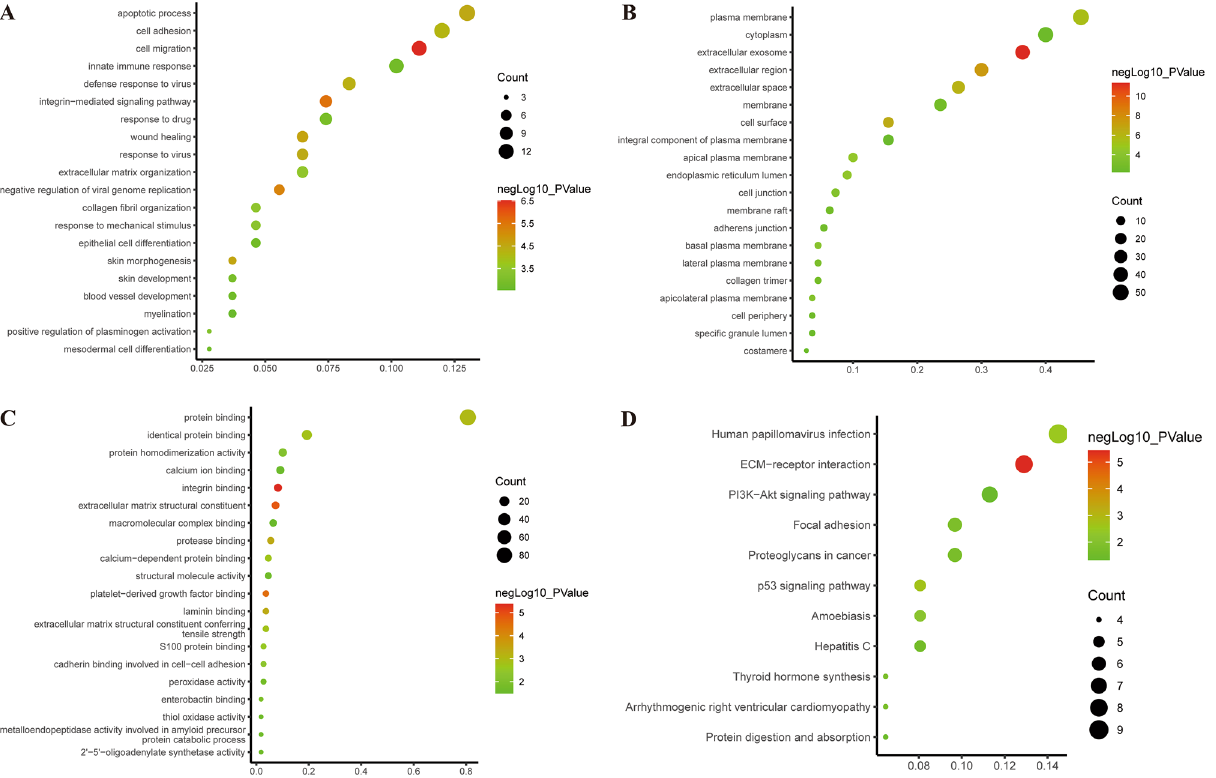
Figure 2. The top 20 GO and significantly enriched KEGG pathways. ( A ) BP; ( B ) CC; ( C ) MF; ( D ) KEGG pathways. The Y-axis indicates remarkably enriched items, the X-axis shows the degree of enrichment; P-value are indicated by the color of the dots, and the size of the dots represents the number genes enriched in the GO and KEGG